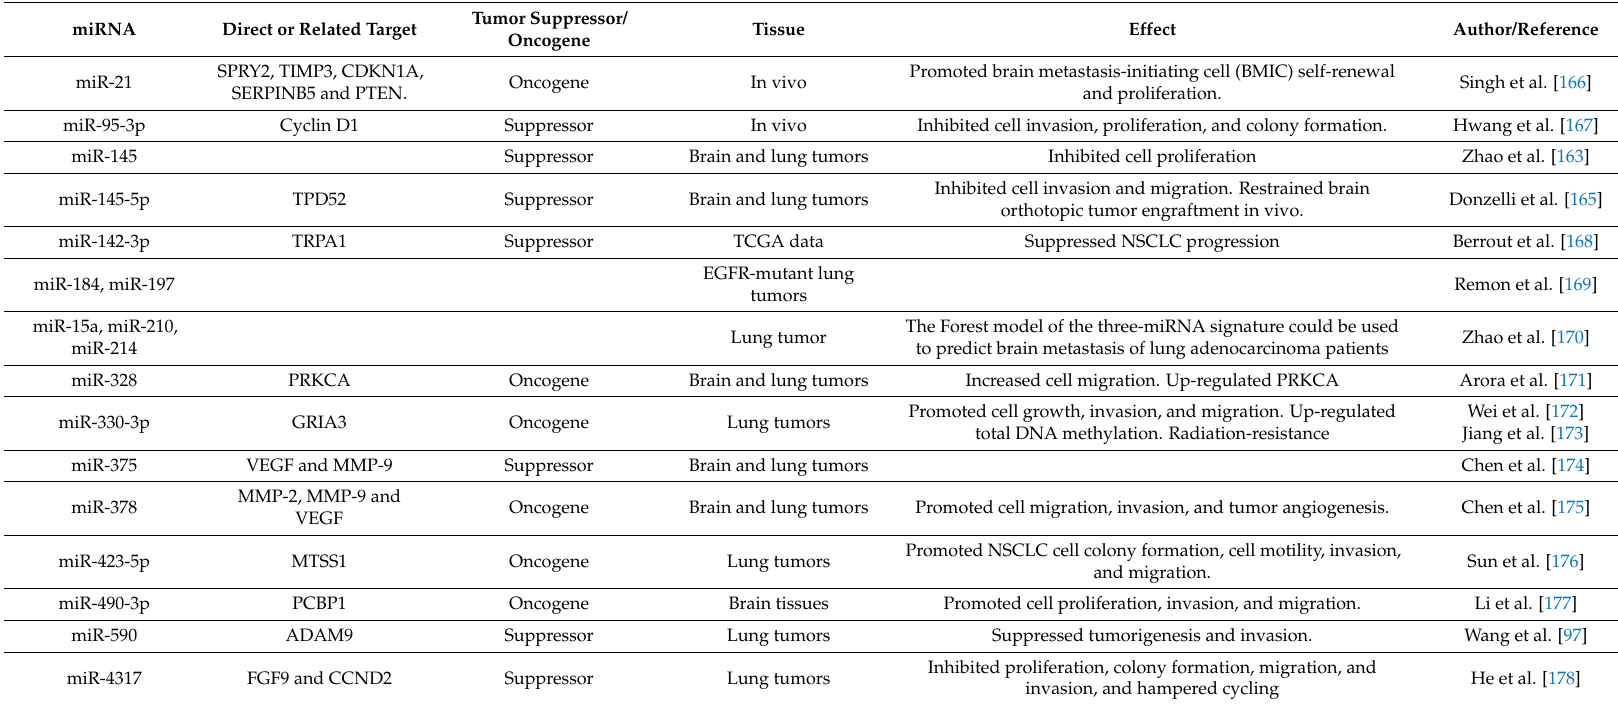
Table 3. Brain metastasis-related microRNAs in